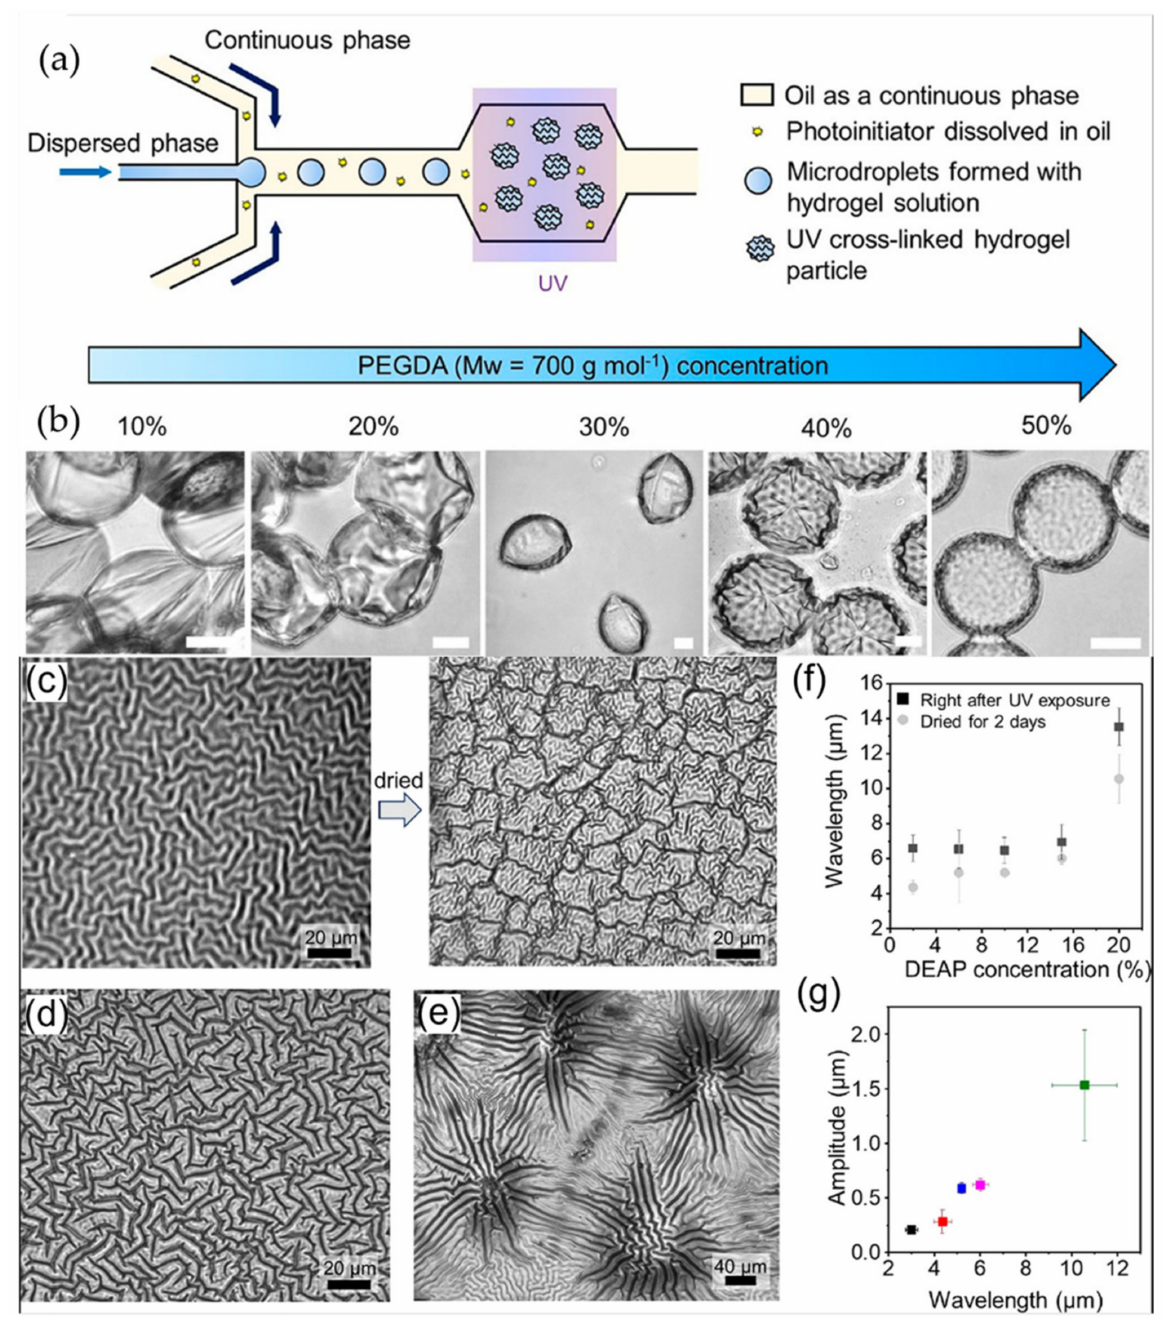
Figure 10. ( a ) Schematic representation of wrinkled hydrogel particles formation, using an oil-water interface, ( b ) Effect of polymer concentration on hydrogel morphology, ( c – e ) Labyrinth wrinkle formation and its contraction, and ( f , g ) Effect of photoinitiator in wrinkles dimensions. Reproduced with permission from reference [56]. Copyright 2021, American Chemical Society